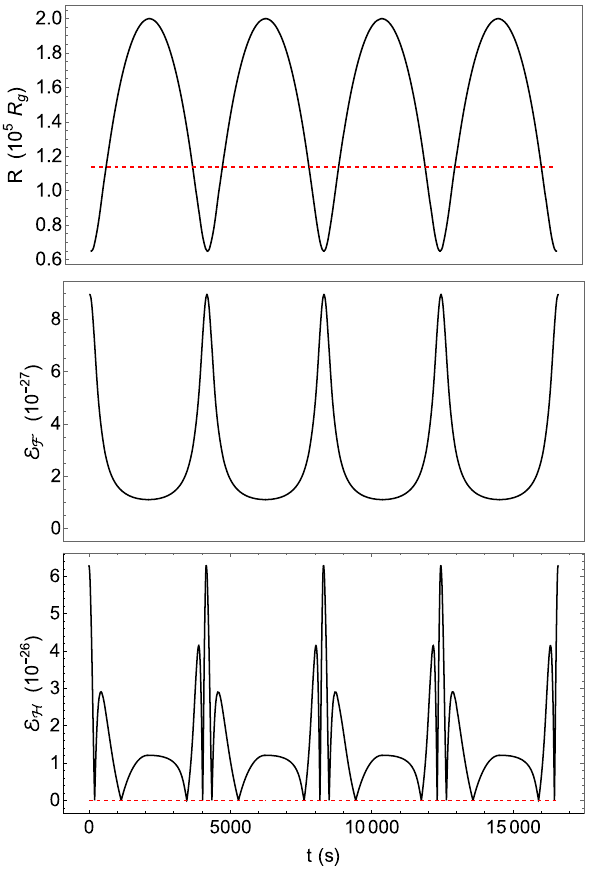
Fig. 1 Plots of the functions R ( t ) , E F ( t ) , and E H ( t ) . Upper panel : time evolution of the modulus of the relative radius (cf. Eq. (125)); the horizontalreddashedlinecorrespondstoitsaveragevalue(seeTable1). Middle panel : trend of E F ( t ) (see Eq. (138a)). Lower panel : behavior of E H ( t ) (cf. Eq. (138b)); the horizontal red dashed line represents the modulus of the mean EC contribution, which amounts to 9 . 31 × 10 − 53